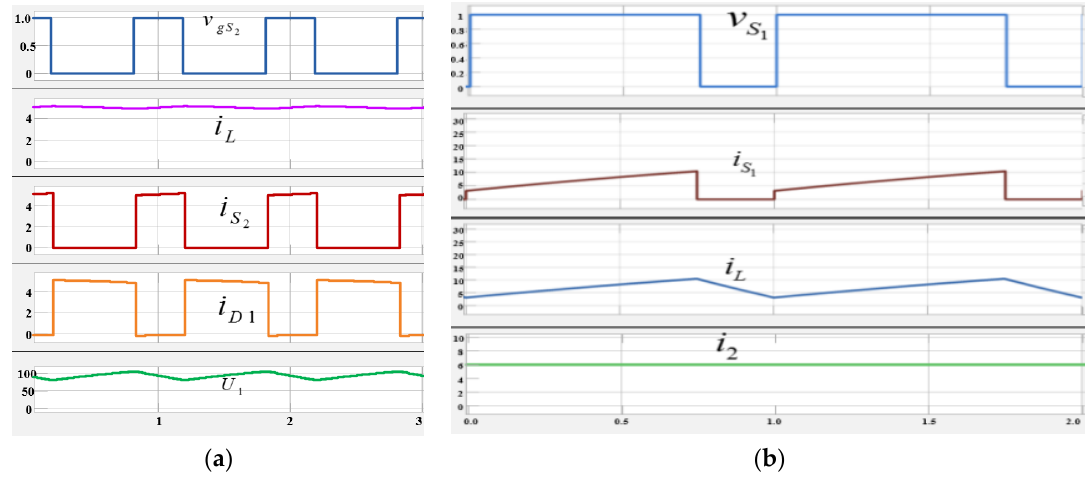
Figure 13. Simulation results for the converter under non-isolated mode: ( a ) the forward converter under non-isolated mode; and ( b ) the reserve converter under non-isolated mode.